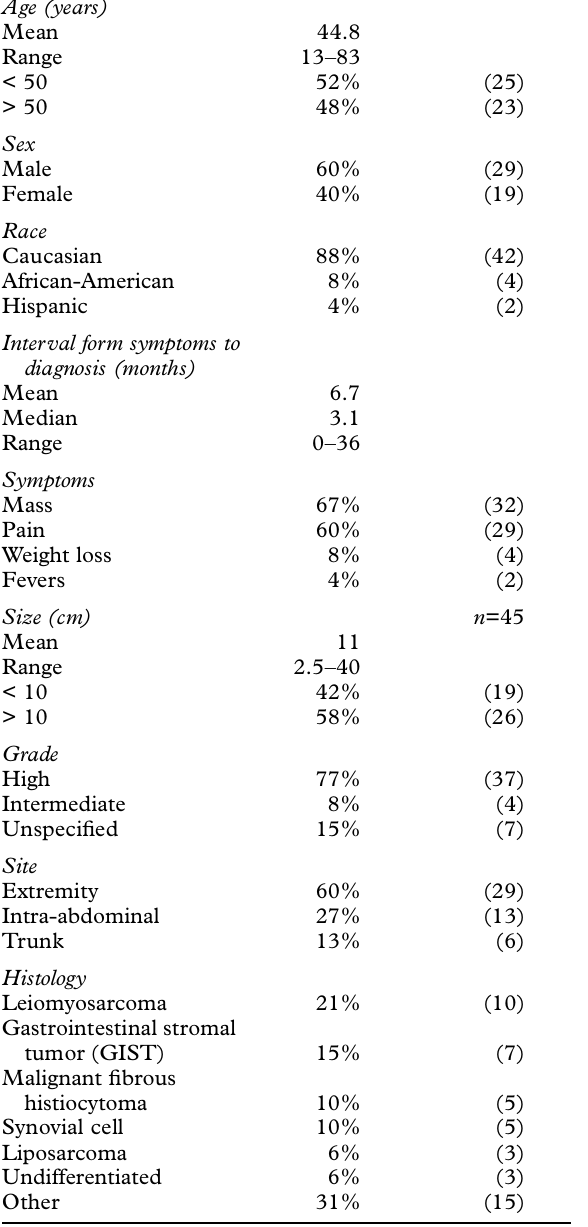
Table 1. Characteristics of 48 patients with a soft tissue sarcoma and synchronous metastases